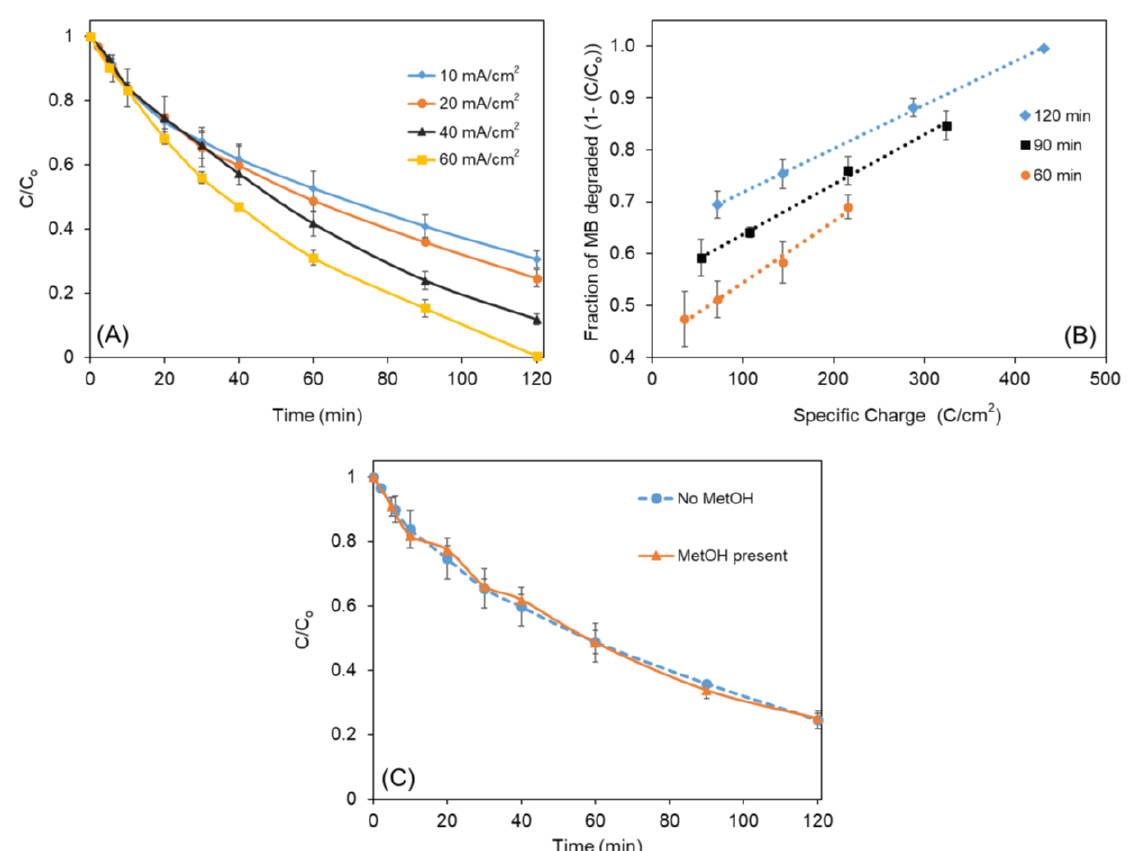
Figure 2. ( A ) Electrochemical degradation of MB (50 mg/L) on the Ni 0.6 Co 0.4 -oxide anode recorded at different current densities and as a function of time; ( B ) Fraction of the initial MB degraded as a function of charge passed through the anode after ( ● ) 60, ( ■ ) 90 and ( ) 120 min of degradation. Electrolyte: 0.17 M Na 2 SO 4 aqueous solution; ( C ) Effect of the presence of 0.2 M methanol in the electrolyte on the degradation of MB at 20 mA/cm 2 .